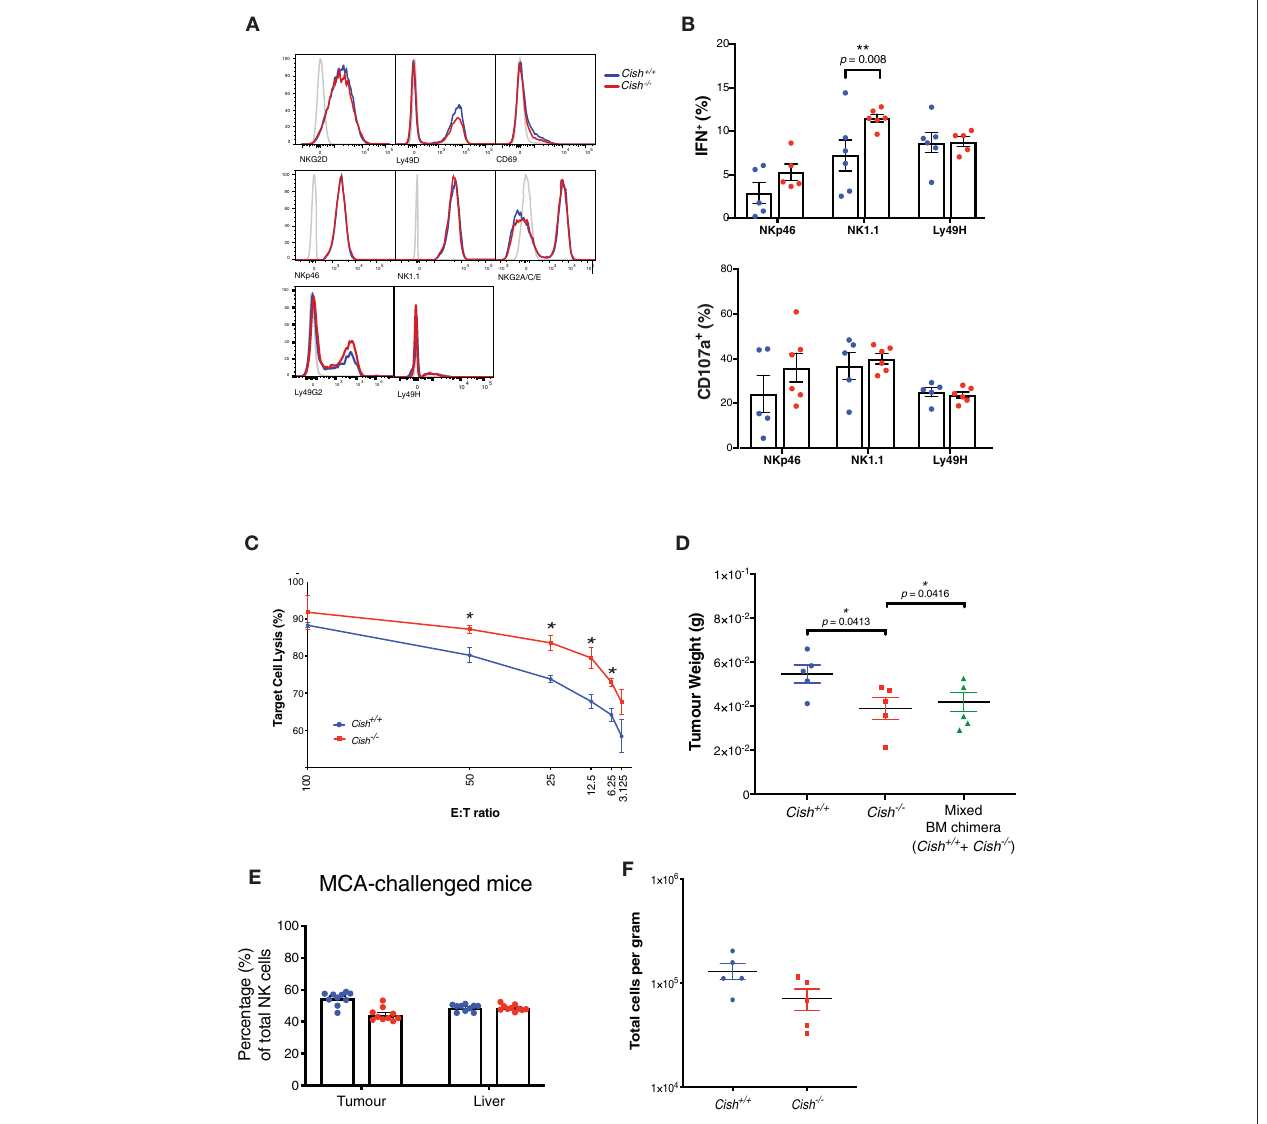
FIGURE 6 | CIS lowers the activation threshold in NK cells and increases anti-tumor function on a per cell basis. (A) Splenic NK cells from Cish + / + and Cish − / − mice were phenotypically analyzed by flow cytometry for activating receptor expression. Representative histograms of receptor expression are shown. (B) Total splenic cells were harvested from 6 to 8 week-old Cish + / + and Cish − / − mice and depleted of red blood cells. Cells were cross-linked with anti-NK1.1, anti-NKp46, and anti-Ly49H antibodies for 4h in the absence of IL-15. Flow cytometric analysis of NK cells and their IFN- γ production and CD107a (LAMP-1) expression was assessed after 4h. ** p < 0.01 (unpaired Student’s t -test). (C) Splenic NK cells were purified from non-tumor bearing Cish + / + and Cish − / − mice and cultured with MCA targets at the indicated effector:target (E:T) ratios. Target cell lysis was quantified by detecting the release of a fluorescent cytoplasmic dye into the culture media after 4h. * p < 0.05 (unpaired Student’s t -test). (D) Female 6–8 week-old reconstituted Cish + / + , Cish − / − and mixed Cish + / + and Cish − / − BM chimeras were subcutaneously inoculated with 1 × 10 5 MCA cells. Tumors were excised after 14 days and weighed. * p < 0.05 (unpaired Student’s t -test). (E) Tumors and livers from mixed Cish + / + and Cish − / − BM chimeras were excised 14 days after tumor inoculation and NK cell infiltrate was measured using flow cytometric analysis of Ly5.1 and Ly5.2 to deduce NK cell donor origin. (F) Tumors from reconstituted Cish + / + and Cish − / − mice were analyzed using flow cytometry and total NK numbers enumerated. ( A , representative plots from n = 3 biological replicates; B , mean ± s.e.m. of n = 3 biological replicates from one experiment representative of three independent experiments with similar results. C , mean ± s.e.m. of n = 3 biological replicates at each E:T ratio timepoint; D–F , mean ± s.e.m of n ≥ 5 biological replicates of one experiment representative of two independent experiments with similar results).